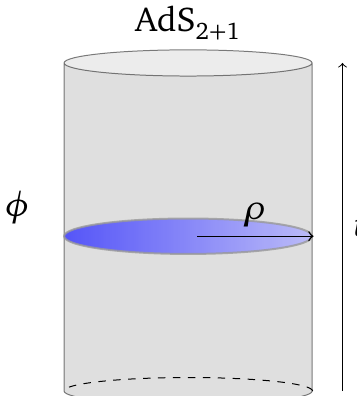
Figure 1: AdS spacetime in the global coordinates (2). The conformal bound- 2 + 1 ary coincides with the surface of the cylinder and is located at ρ → 1. A constant time-slice (blue) is isomorphic to the Poincaré disk D 2 . The induced metric on this manifold is given by (3), which has an equivalent formulation in Poincaré coordinates